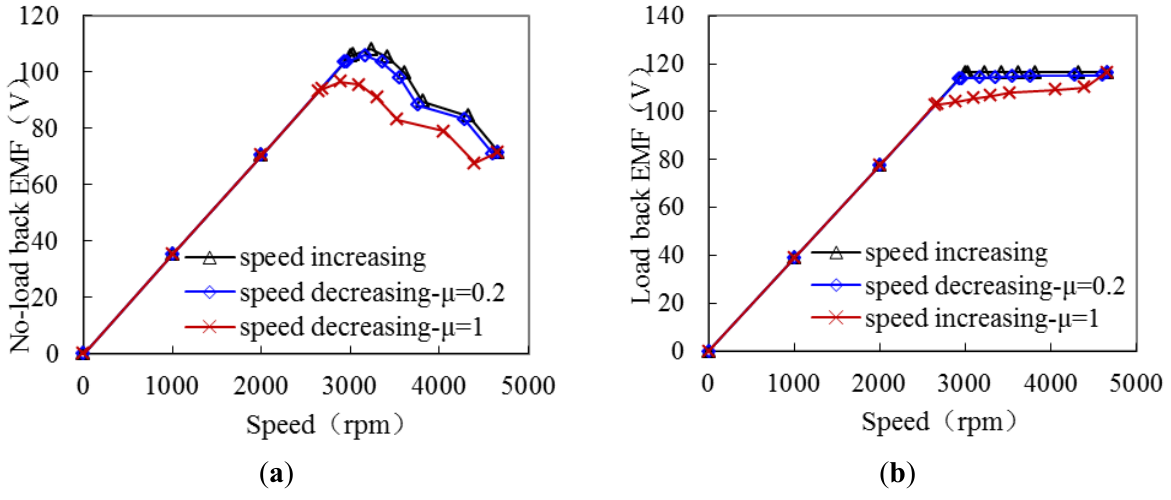
Figure 24. Relationship of back EMF versus speed: ( a ) no-load back EMF; ( b ) load back EMF.